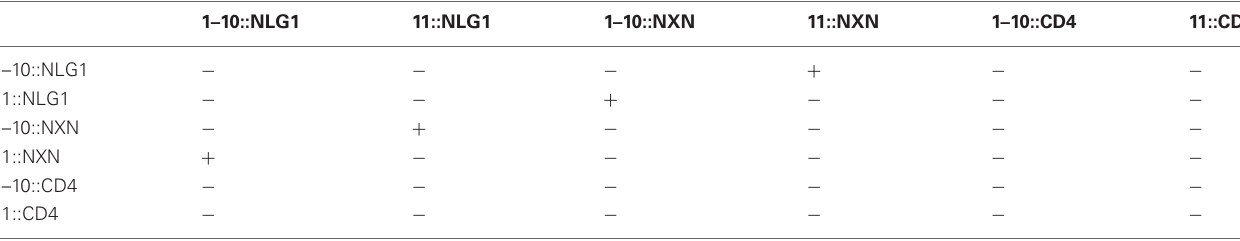
Table 1 | GRASP signal at cell-cell contacts of various